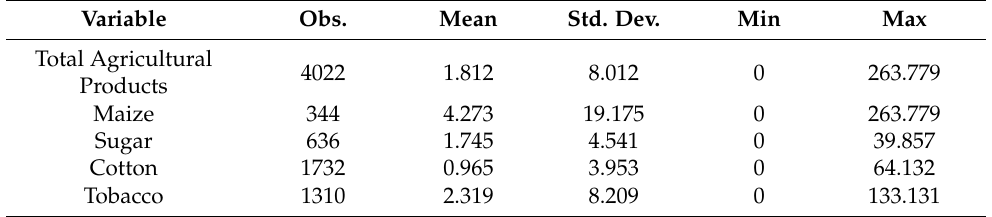
Table 1. Descriptive statistics of exports.